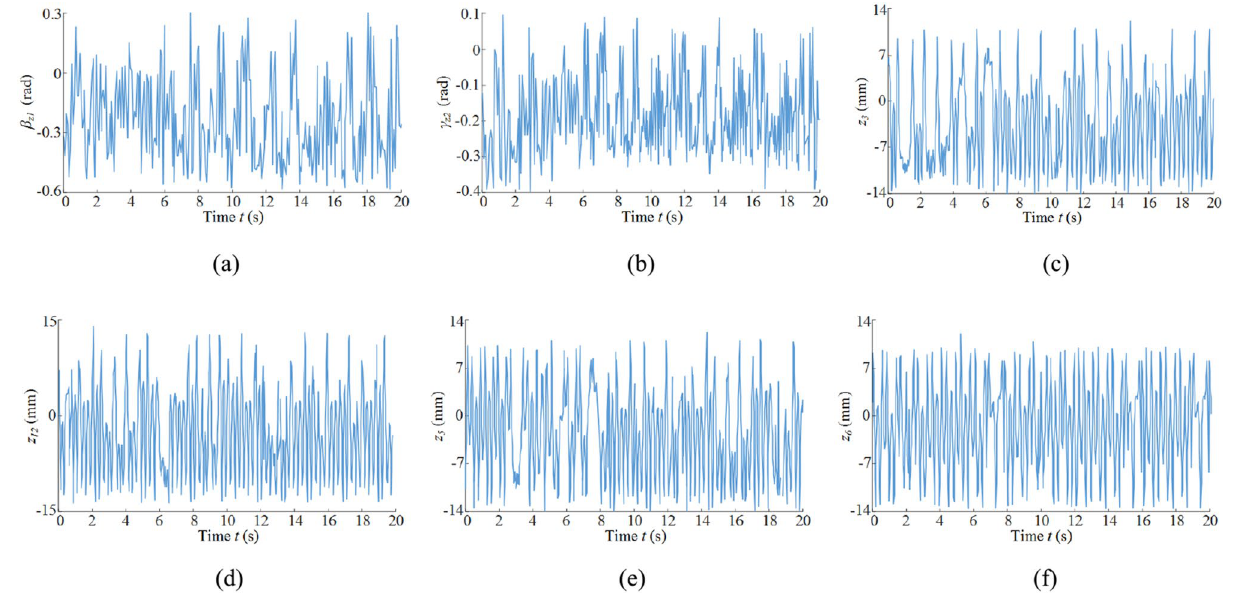
Figure 7. Vibration displacement and swing curve: ( a ) vibration-induced swing for front drum, ( b ) vibration- induced swing for front ranging arm, ( c ) vibration-induced displacement for front traction unit, ( d ) vibration- induced displacement for front walking unit, ( e ) vibration-induced displacement for front support unit, ( f ) vibration-induced displacement for body.